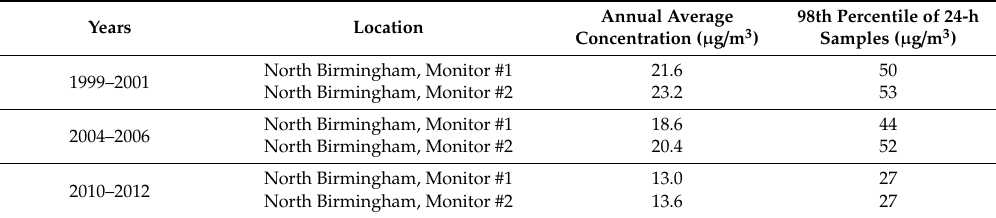
Table 2. PM 2.5 sampling results from the North Birmingham monitoring stations